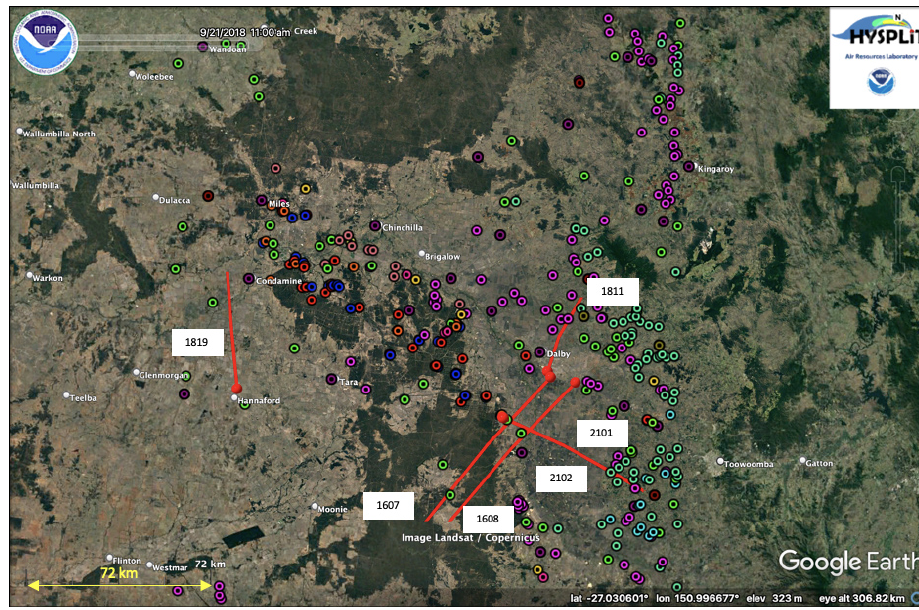
Figure A5. Two-hour HYSPLIT back-trajectory path lines (red) for the points used in the feedlot Keeling-model regression analysis. Each green dot indicates the position of a feedlot (image © Google